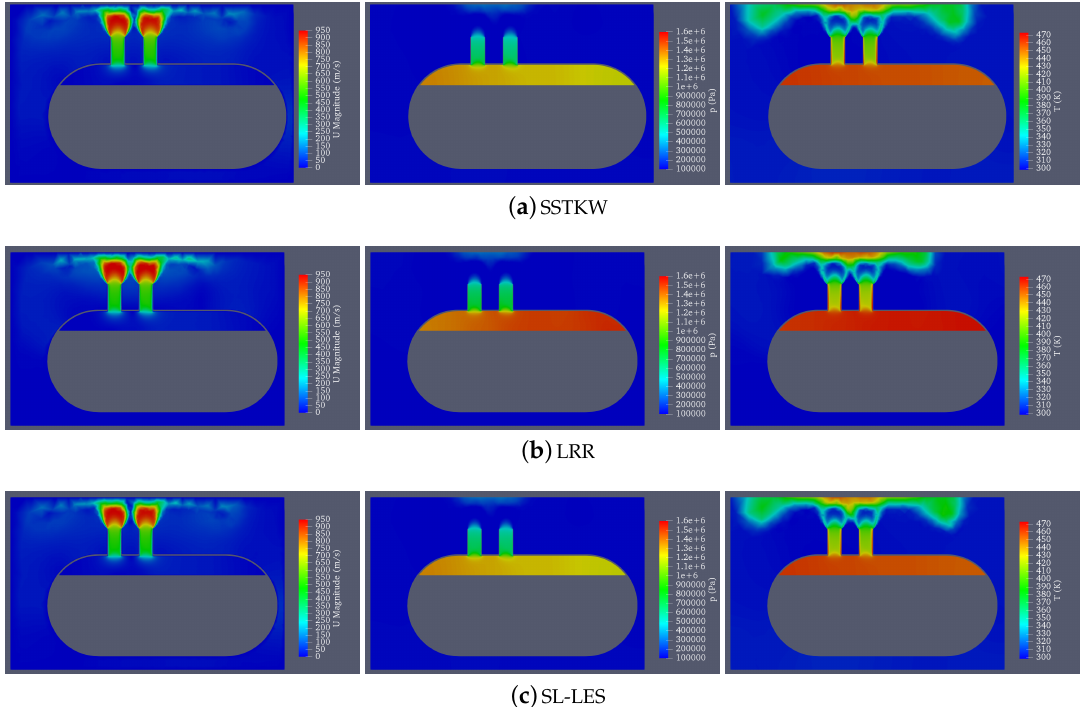
Figure 15. The distribution of velocity, pressure, and temperature of the simulation results of ( a ) the SSTKW, ( b ) LRR, and ( c ) SL-LES model based on PRTFOAM at t = 0.02 s. At this time, the temperature of steam in PRT gradually decreased to 458 K, and the pressure decreased to 1.29 MPa. The simulation results of the three turbulence models are basically the same, and the process of steam dumping is the same as common sense. However, the simulated results of LRR model show that at the same time, the pressure and temperature in the chamber of the PRT are significantly higher than those of the other two models. The simulated temperature of LRR is 464 K (190.85 ◦ C), while that of other models is only 458 K (184.85 ◦ C). Similarly, the simulated pressure of LRR is 1.41 MPa, while that of other models is only 1.29